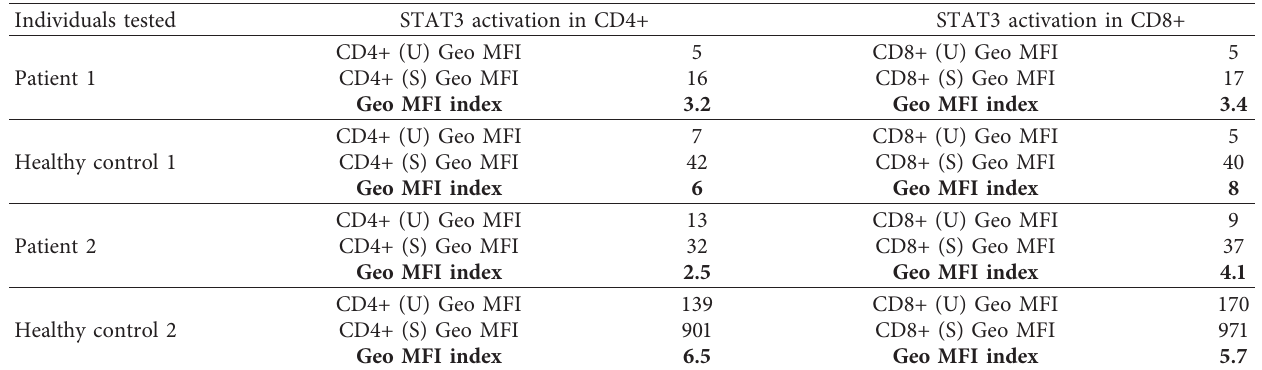
Table 2: Evaluation of STAT3 signaling pathway activation in